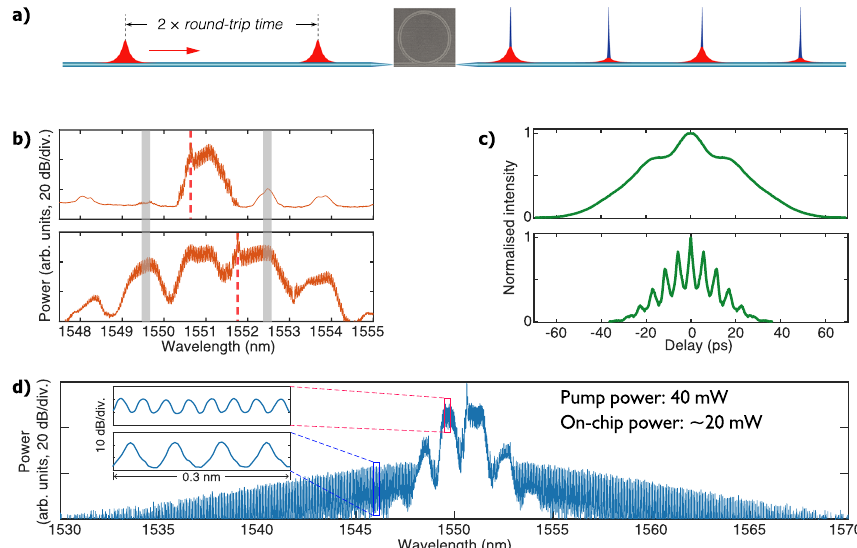
Fig. 4 Subharmonic pumping using a gain-switched Fabry – Perot laser. a Schematic of the subharmonic pulse-pumping method. b GSL spectra obtained with the master laser injecting around the centre of a lasing mode at 1550.7nm (upper panel) and between two lasing modes (lower panel), respectively. The grey stripes indicate the positions of the central mode ’ s two neighbouring FP modes. The red dashed lines indicate the positions of the injection. c The measured autocorrelation traces of the GSL pulses in single-mode lasing (upper panel) and dual-mode lasing (lower panel) states, respectively. d The optical spectrum of the soliton microcomb driven by the offset-injection-locked FP GSL. The insets show the enlarged partial spectra of the GSL comb with f f gs of 4.86 GHz and the microcomb with rep of 9.72 GHz,